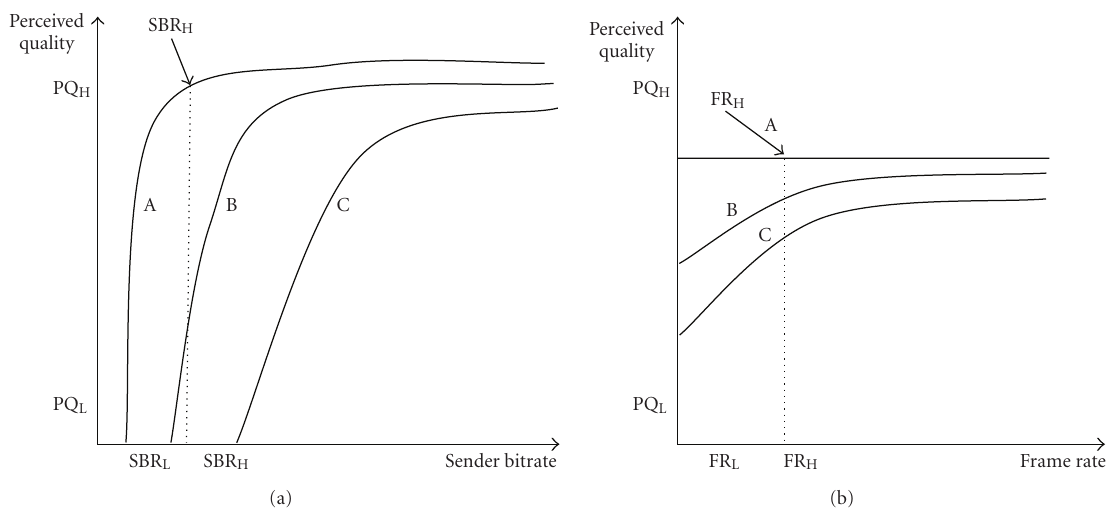
Figure 5: (a) Impact of dynamics on the video quality versus sender bitrate curves. (b) Impact of dynamics on the video quality versus frame rate curves.